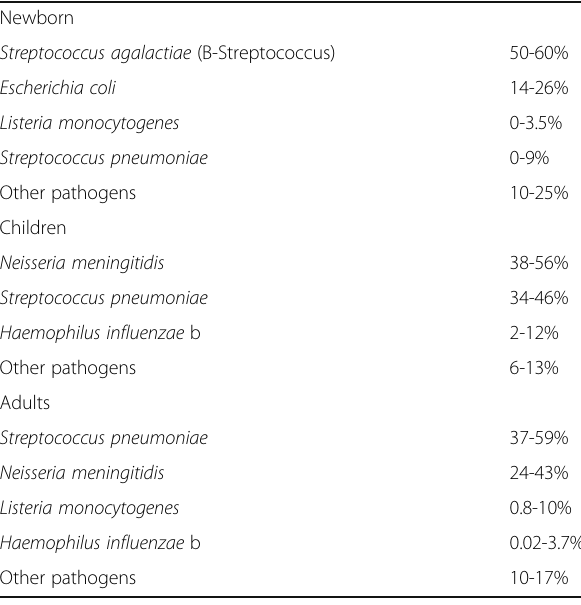
Table 6 Overview of bacterial pathogens as a function of age